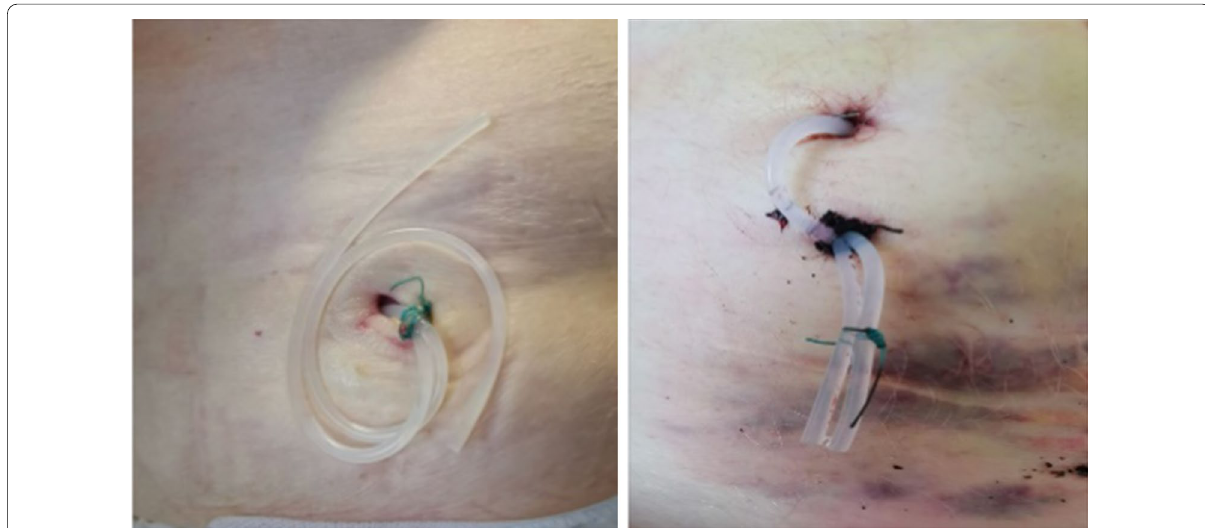
Fig. 3 Hidden ileostomy: the silicone loop is fixed to the skin in the right lower